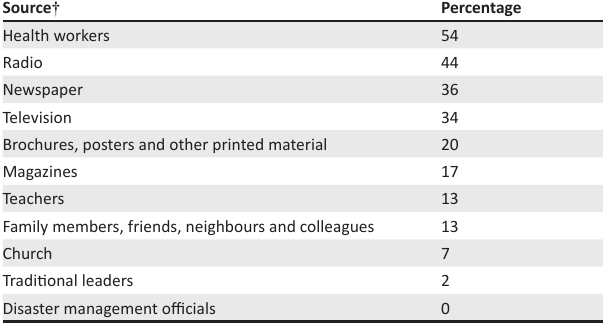
TABLE 2: Respondents’ information sources on cholera prevention.